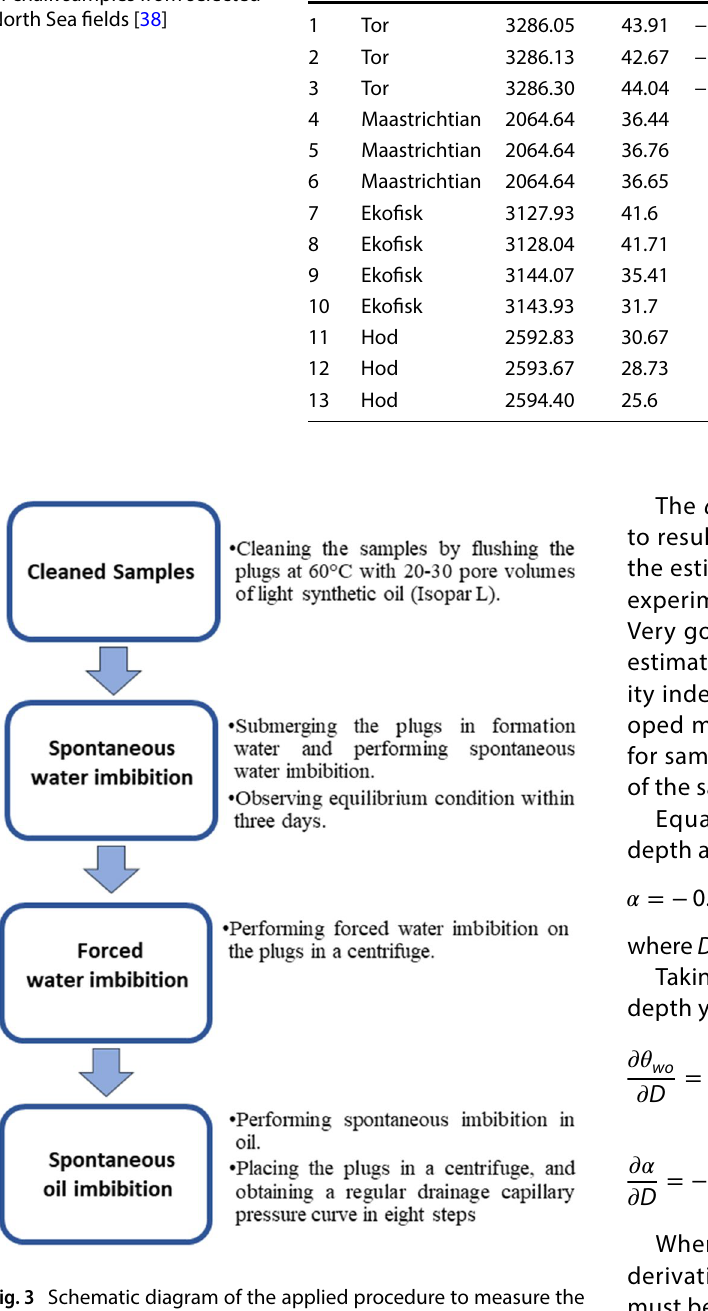
Fig. 3 Schematic diagram of the applied procedure to measure the Amott wettability index values